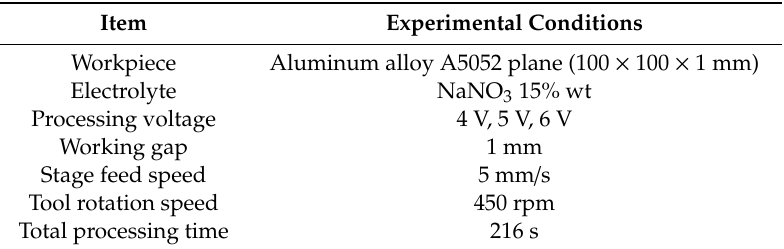
Table 1. Experimental conditions of electrolysis in EMAF